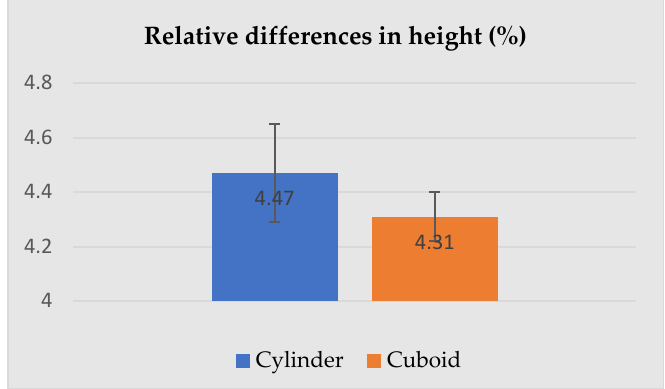
Figure 8. Relative differences in the height of the human silhouette circumscribed by a cylinder and cuboid attributable to PPE use.